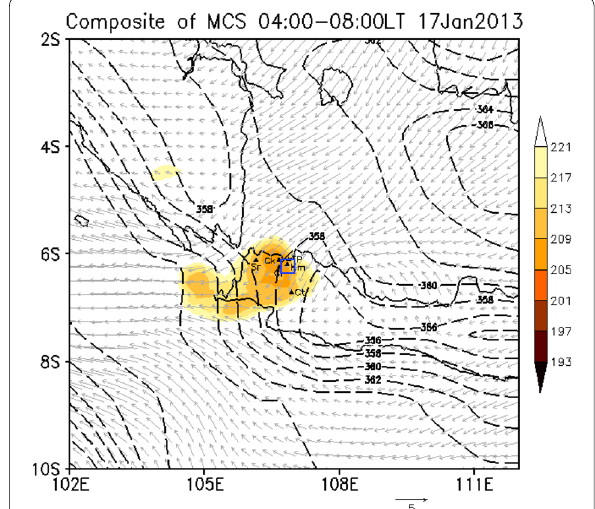
Fig. 9 As in Fig. 8 but valid for the second MCS. The TBB composite periods are at 04:00–08:00 LT 17 January 2013, while surface wind vector perturbation and surface equivalent potential temperature are at 07:00 LT 17 January